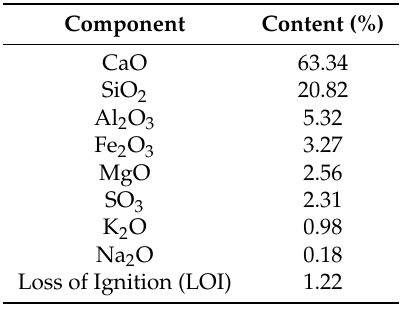
Table 1. Chemical composition of cement.